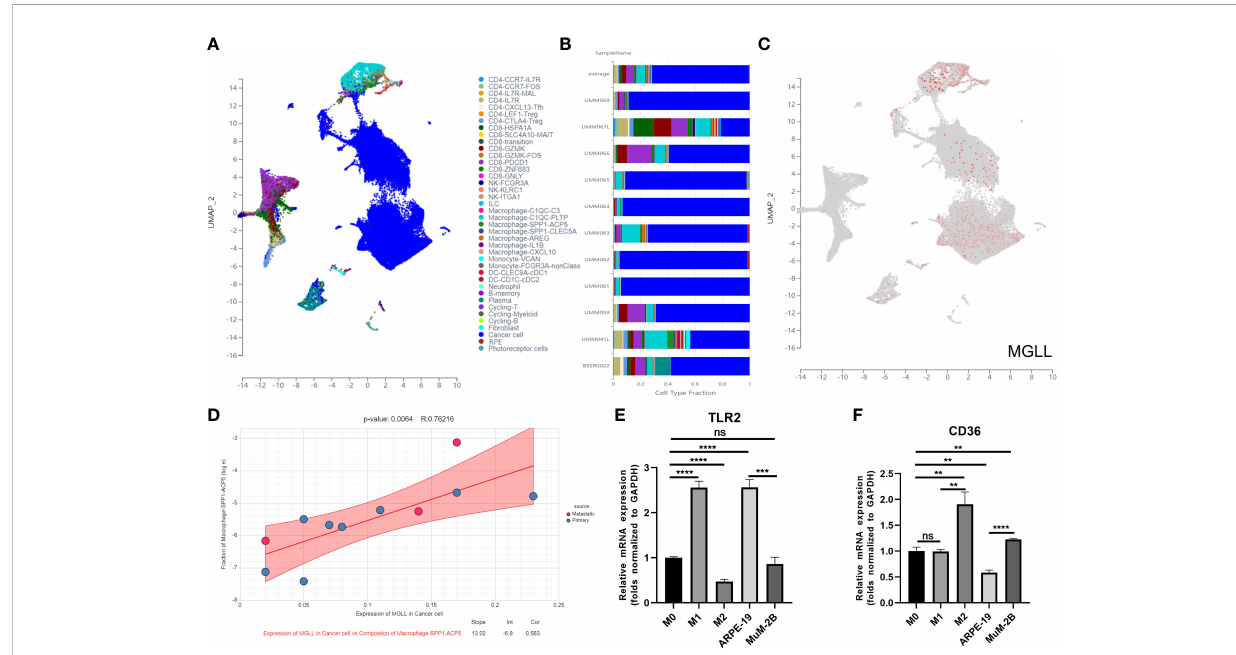
FIGURE 9 MGLL affects macrophage polarization in the TME. (A) Distribution of different cell clusters in the UMAP plot. (B) The fraction of each sample depends on the type of cell. (C) MGLL expression in distinct clusters of cells. (D) Correlation analysis between expression of MGLL in cancer cells and composition of in fi ltrating macrophages (SPP1-ACP5). (E) THP-1 macrophages were polarized towards an M1-like phenotype by the conditioned media of ARPE-19 cells with reduced MGLL expression. (F) THP-1 macrophages were polarized to an M2-like phenotype by the conditioned medium of MuM-2B cells with highly expressed MGLL. (n = 3, paired Student ’ s t-test) **p < 0.01; ***p < 0.001; ****p < 0.0001 ns, no signi fi